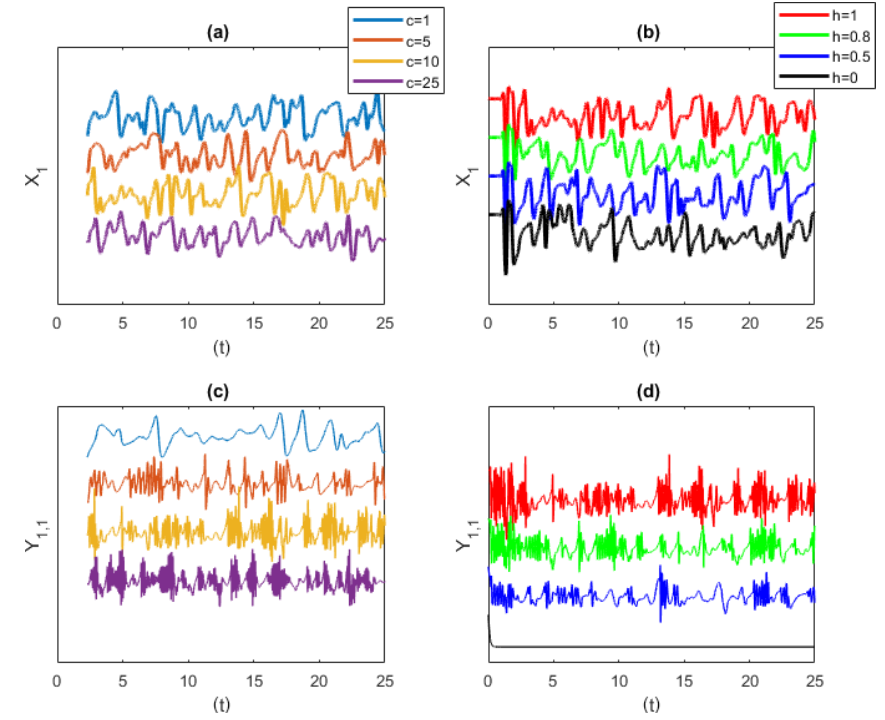
Figure 6. Lorenz 1996 simulations for the large-scale variable X 1 (a, b) and small-scale variable Y 1 , 1 (c, d) . Panels (a, c) show simulations varying c at fixed h = 1. The larger the c , the more intermittent the behaviour of the fast scales. Panels (b, d) show simulations varying the coupling h for fixed c = 10. When h = 0, there is no small-scale dynamics. y axes are in arbitrary units, and time series are shifted for better